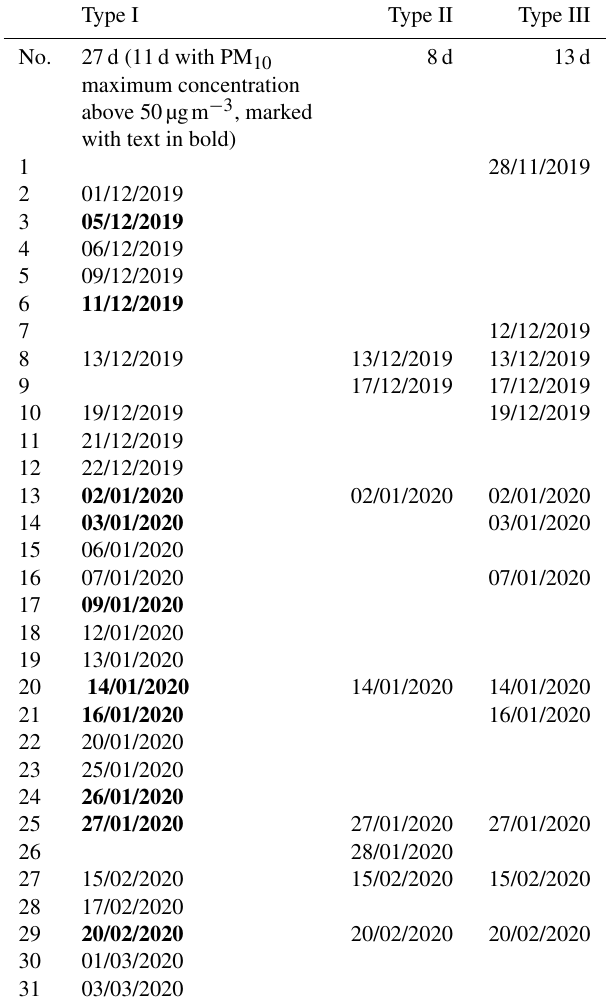
Table A4. List of the measurement campaign with the specified PM 10 profile observed during the selected